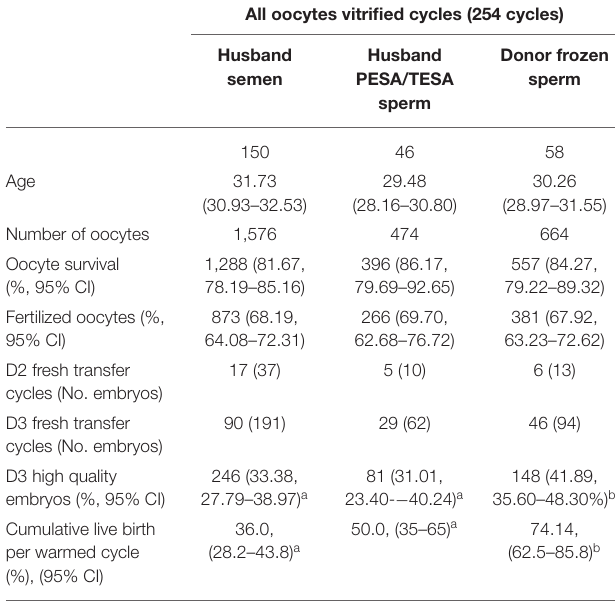
TABLE 5 | Sibling oocytes compared in part-oocyte-vitrified cycles (survival of oocytes inseminated with sperm from the husband). Cycles